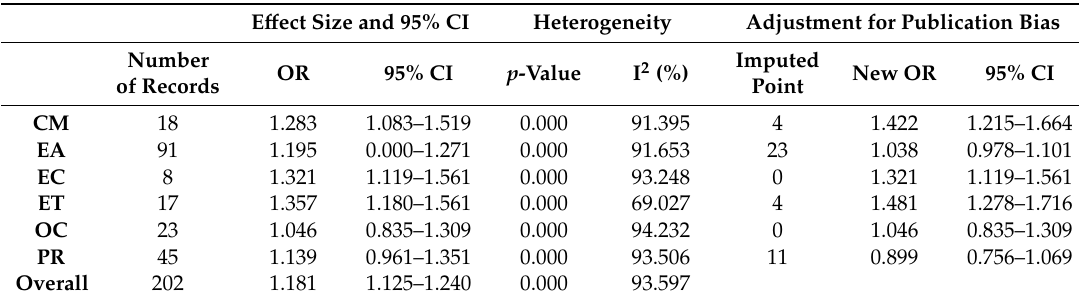
Table 2. Random e ff ects sizes between work–life balance arrangement (WLBA) and organisational performance (OP) (CM, EA, EC, ET, OC, and PR).